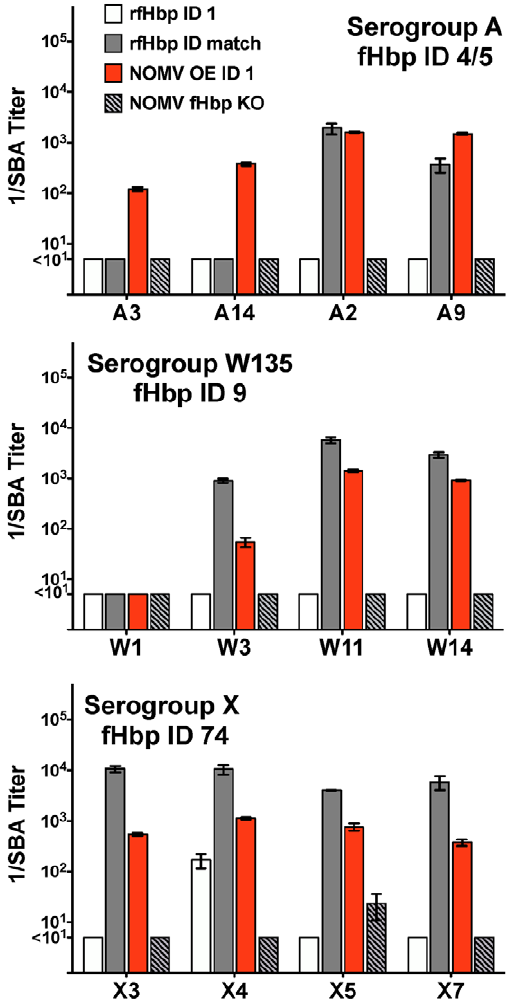
immunized with recombinant fHbp vaccines, or NOMV vac- cines prepared from mutants of group B strain H44/76 with over-expressed or inactivated fHbp ID 1. White bars, recombinant fHbp ID 1; gray bars, recombinant fHbp ID vaccine that matched that of the test isolates (ID 4, serogroup A; ID 9, serogroup W-135; and ID 74, serogroup X); orange bars, NOMV vaccine from a mutant of H44/76 with over-expressed fHbp ID1; gray bars with hatches, NOMV vaccine from a mutant of H44/76 with fHbp knocked-out. Titers are means 6 ranges of serum dilutions that gave 50% decreases in CFU/ml after one hr incubation with human complement measured in at least two assays. The dose of recombinant fHbp vaccines was 20 m g, which was administered with Freund’s complete for dose 1 and incomplete adjuvant for doses 2 and 3. The dose of the NOMV vaccines was 1.25 m g of total protein adsorbed with 170 m g of aluminum hydroxide.